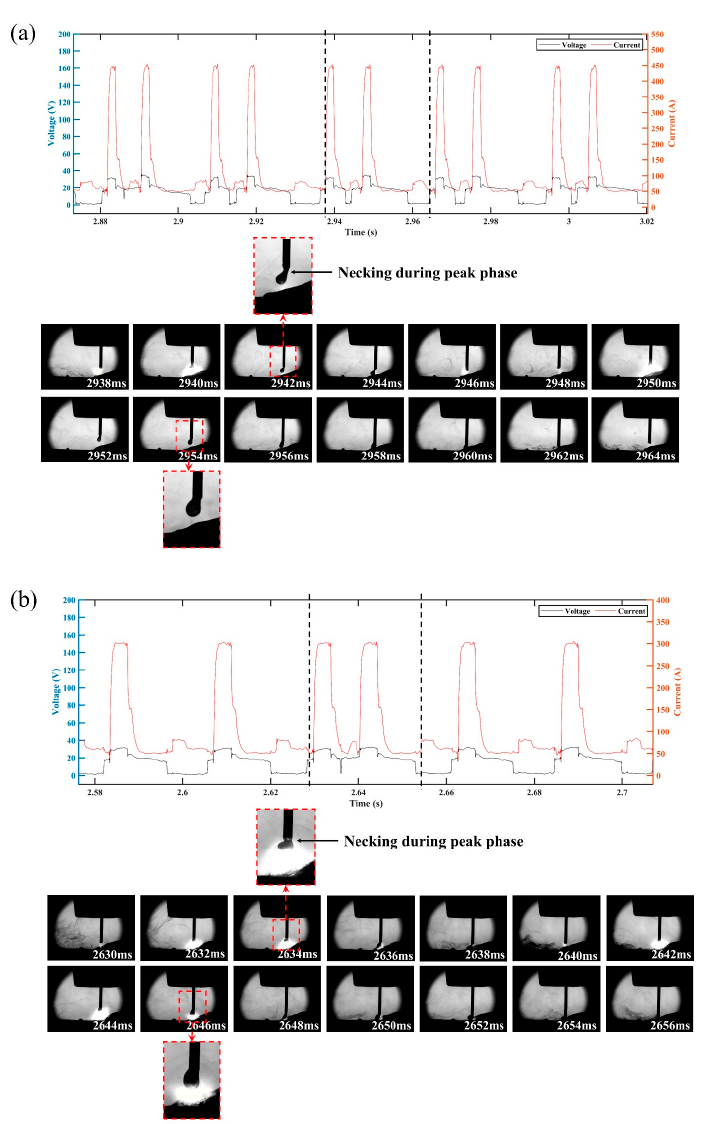
Figure 8. Electrical waveforms and droplet transfer process at ( a ) I_boost = 450 A and ( b ) t_I_boost = 4 ms.